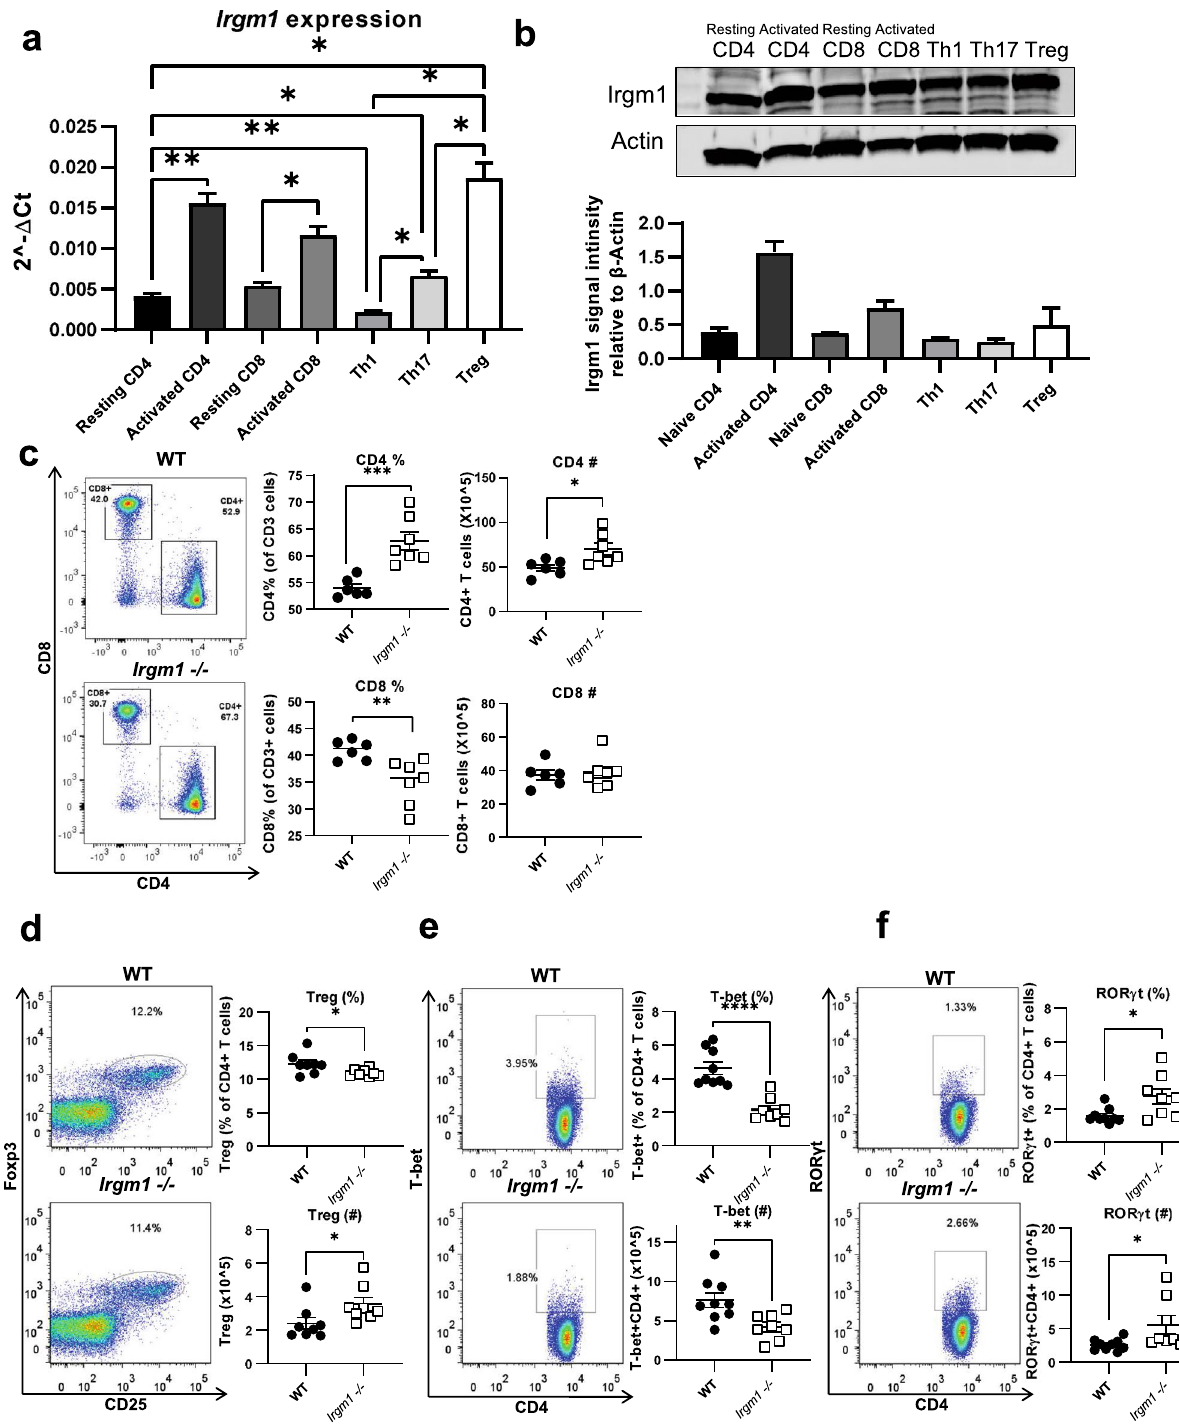
Figure 1. Irgm1 is expressed in T cell populations and its deficiency is associated with changes in T cell proportions. CD4 + and CD8 + T cells were isolated from spleens of C57BL/6 mice and analyzed at rest or activated with plate bound antibodies to CD3 and CD28. CD4 + T cells were further differentiated into Th1, Th17, and Treg cell populations, as detailed in the Methods. ( a ) T cell RNA was generated and Irgm1 gene expression was analyzed by qRT-PCR. (Welch’s ANOVA test p = 0.0002, multiple unpaired t with Welch’s correction used to compare pairs) ( b ) T cell lysates were generated and immunoblotted for Irgm1 protein expression relative to actin (Kruskal–Wallis test p = 0.065, Dunn’s multiple comparisons used to compare pairs). ( c-f ) Splenocytes were isolated from WT and Irgm1 −/− mice, stained and analyzed by flow cytometry for CD4 and CD8 ( c ), CD4 + Foxp3 + (Treg) ( d ), CD4 + T-bet + (Th1) ( e ) and CD4 + RORγt + (Th17) ( f ). Each dot represents a single mouse. (a-c) data are representative of two independent experiments (d-f) data are pooled from 2–3 independent experiments ( n = 8–9 ); error bars represent ± SEM. Mann Whitney test or T-test with Welch’s correction was used to compare groups depending on the normality of the distribution as judged by the Shapiro–Wilk test.. * p < 0.05, ** p < 0.01, *** p < 0.001, **** p <